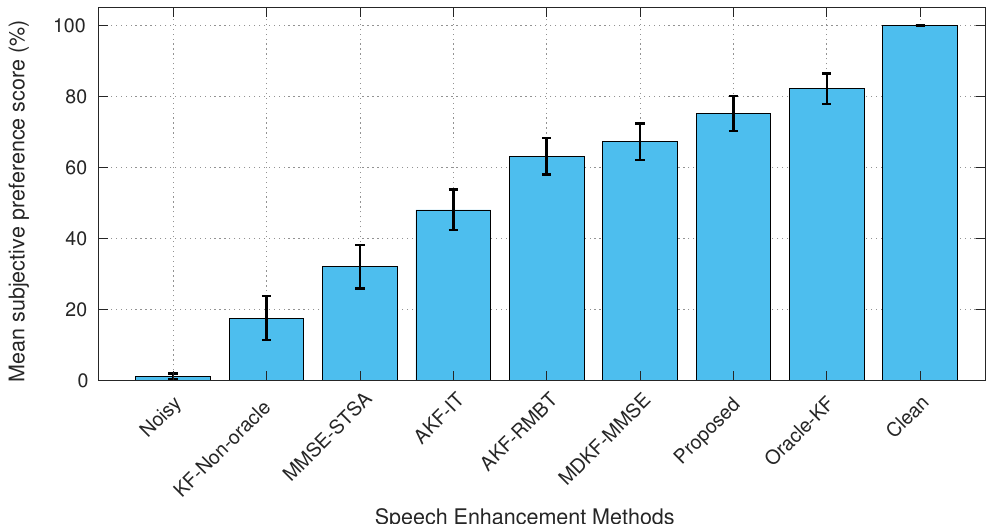
Figure 14. The mean preference score (%) comparison between the proposed and benchmark SEAs for the utterance sp27 corrupted with 5 dB colored f16